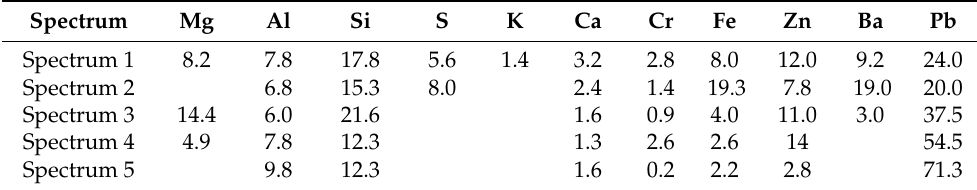
Table 2. Elements detected through EDS analysis of the areas shown in Figure 5b. Results are reported in weight percentage (w%) removing the counts of oxygen and carbon.